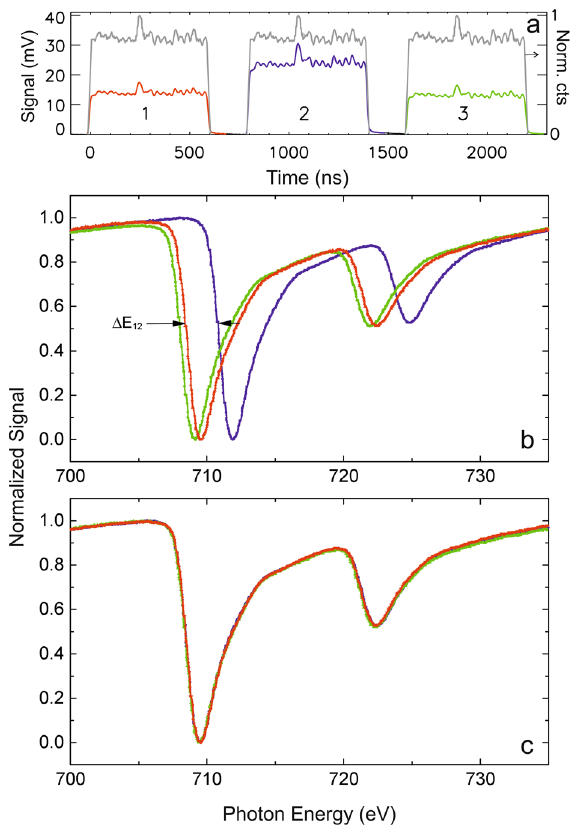
Figure 2. Signals and spectra from a Fe thin film sample using TRIBs simultaneously measured from successive macro pulses. ( a ) APD signal behind the sample revealing the difference of X-ray absorption at 709 eV versus time after the triple turn trigger event. A reference signal from the BESSY II fill-pattern APD detector for the 3 turns is also plotted (grey). ( b ) Normalized APD signals measured in parallel from the macropulses #1 (red), #2 (blue) and #3 (green) during fast scans (300 ms/point) of the photon energy behind the Fe sample in transmission for the TRIBs mode at single island population. Since the time resolution is about 5 ns, individual electron bunches (2 ns separation) are not resolved. ( c ) The same three spectra shift-corrected revealing no change in spectral shape using light emitted from different